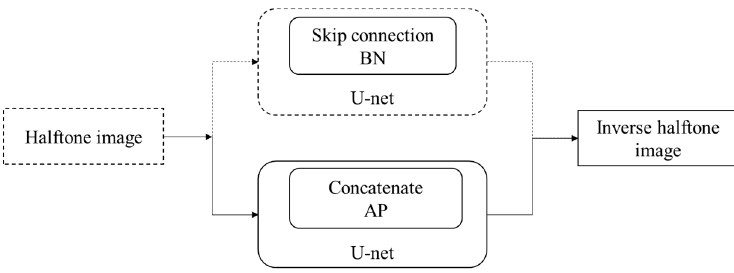
Figure 5. The network architectures in references [17,18]. The networks in references [17,18] are shown in the dotted box and solid box, respectively.